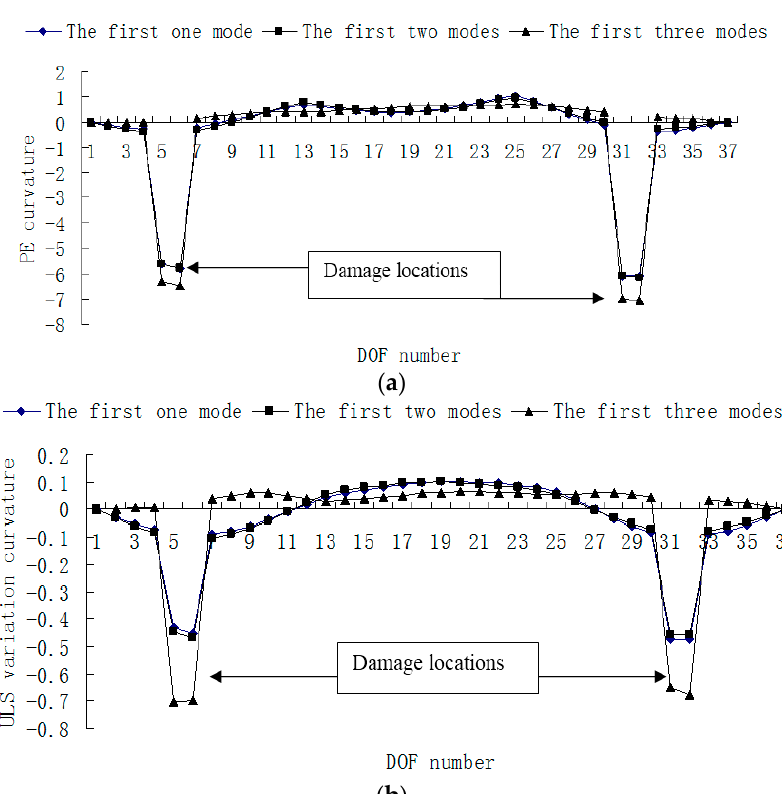
Figure 19. ( a ) Damage index (PE) map using the first one, two and three modes without noise, respectively, when elements 5 and 31 are damaged; ( b ) Damage index (ULS variation) map using the first one, two and three modes without noise, respectively, when elements 5 and 31 are damaged (×10 − 4 ).